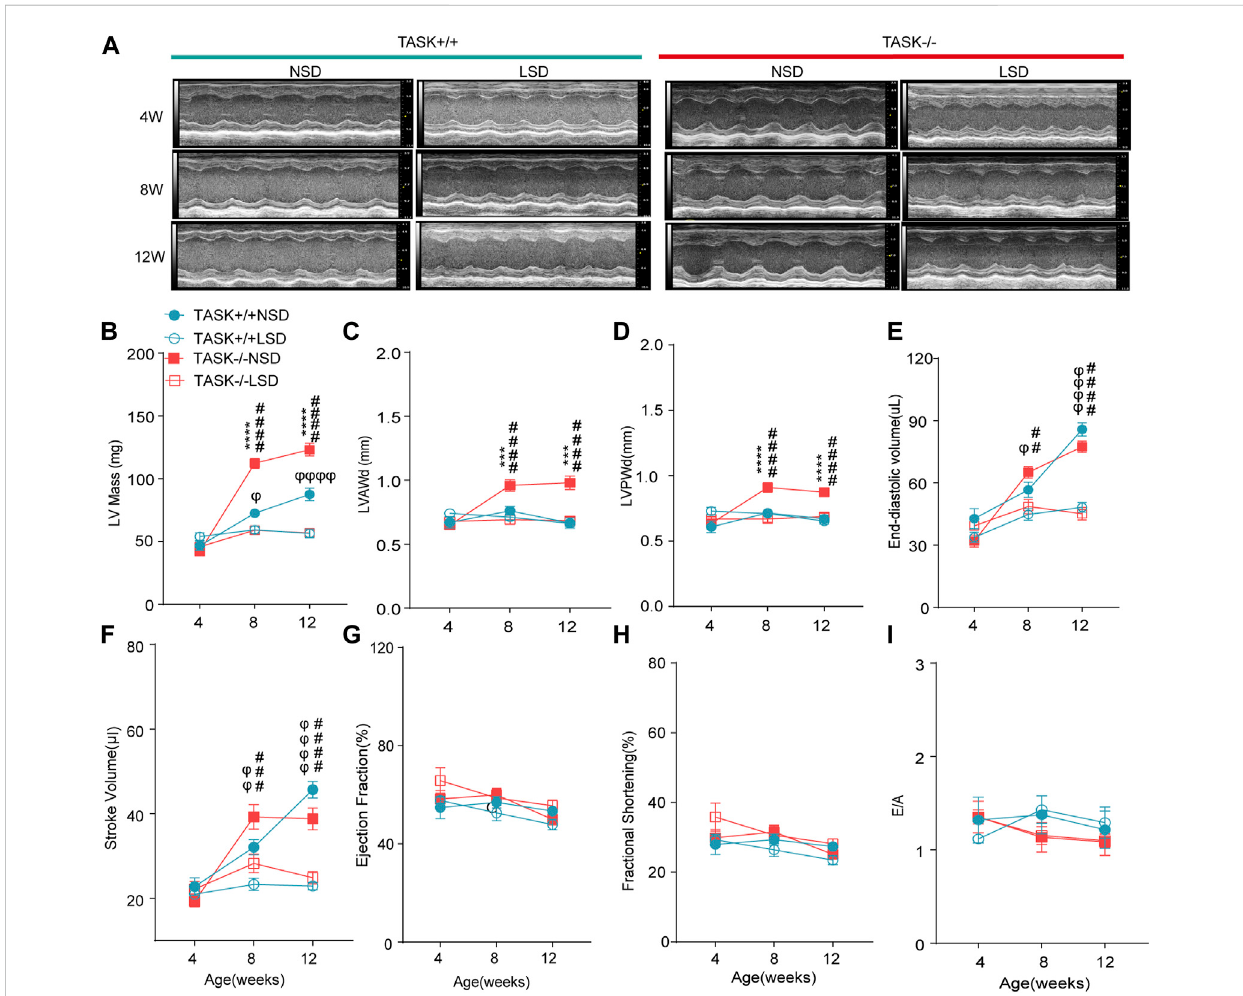
LSD prevents the development of LV hypertrophy in TASK − / − mice. (A) Representative M-mode echocardiogram images of each group of mice at 4 weeks, 8 weeks, and 12 weeks of age. Quantitative comparison of echocardiographic parameter changes in different groups, including LV Mass (B) , LVAWd (C) , LVPWd (D) , LVESD (E) ,stroke volume (F) ,ejectionfractions (G) ,fractionalshortening (H) ,andE/A ratio (I) .Statistical signi fi cance wasanalyzed by two-way ANOVA with Bonferroni ’ s multiple comparison test ( n = 6 mice for each group, p < 0.05). The symbol * marks a comparison between TASK +/+ and TASK − / − mice on a normal diet, and V and # represent a comparison between NSD and LSD in TASK +/+ and TASK − / − mice